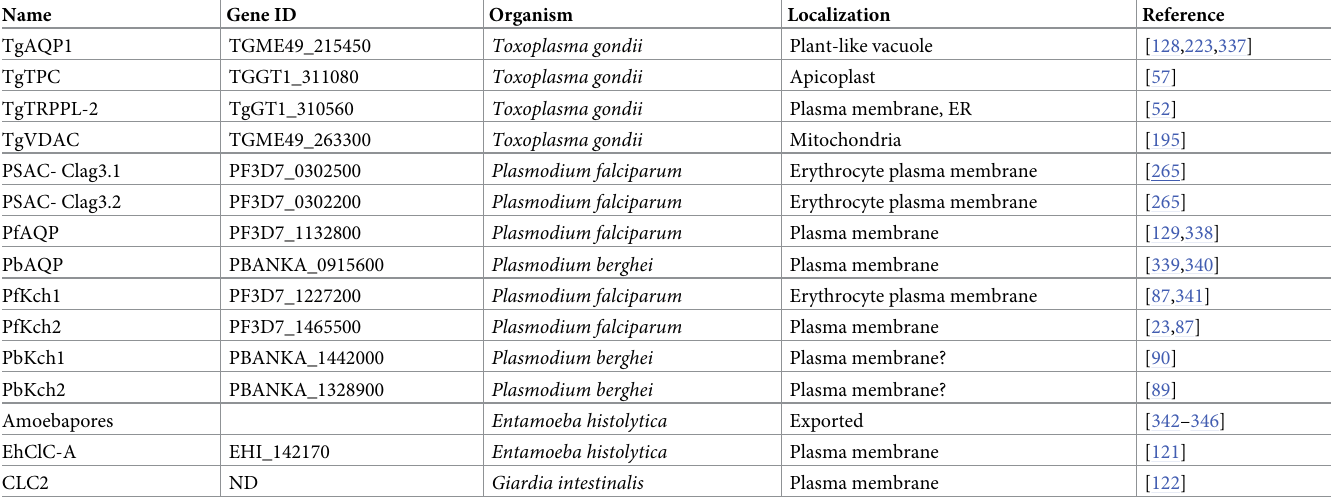
Table 2. Ion channels in apicomplexans and other pathogenic